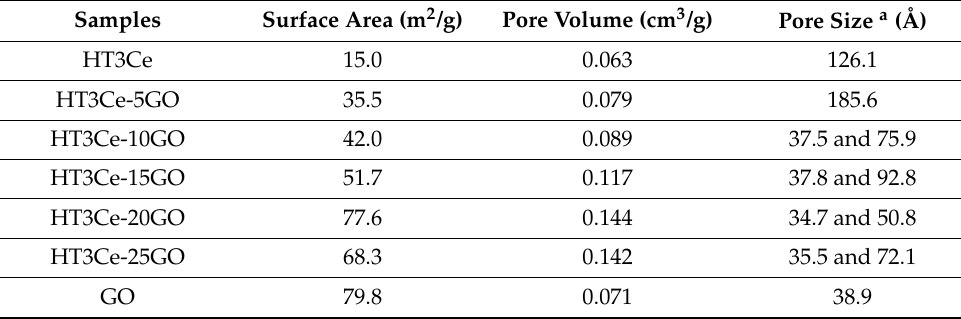
Table 2. Textural properties of the synthesized samples.